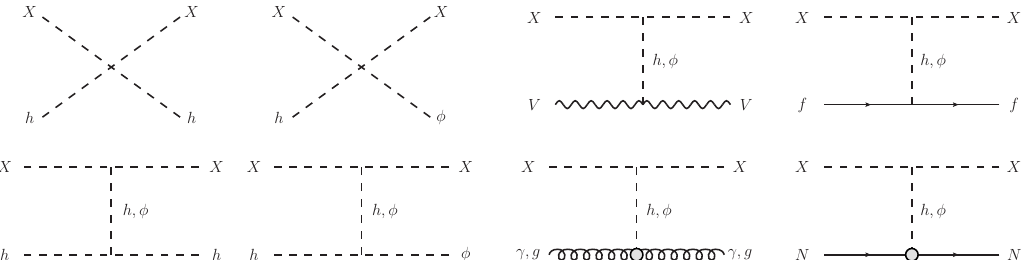
Figure 6: Interactions of the DM with the particles of SM plasma; the SM Higgs, h , el- ementary fermions, f , massive gauge bosons, V , photons, γ , gluons, g , and nucleons N , which can lead to kinetic equilibrium being re-established following the PT. Note at high enough momentum, the DM may instead interact with the partons inside the nucleon, and also break apart the initial nucleon. All corresponding amplitudes of diagrams shown here are suppressed by at least one power of the portal coupling λ h φ